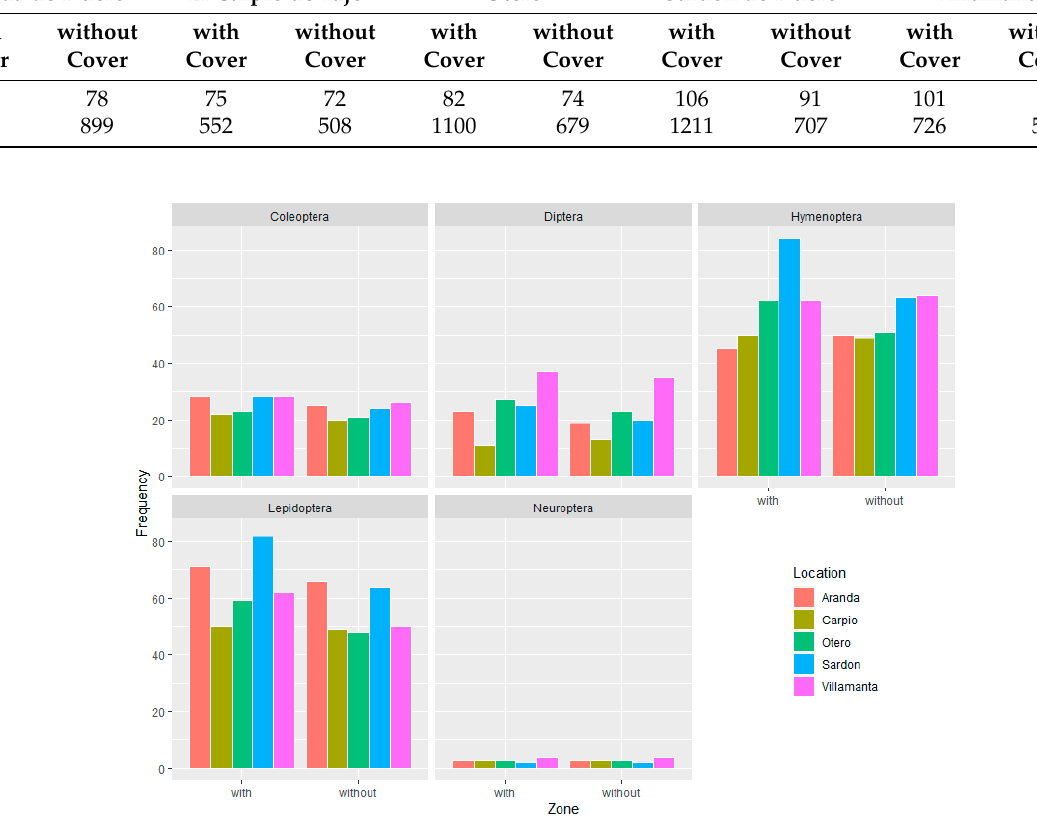
Table 2. The abundance of genera and individuals by vineyard farm and treatment.